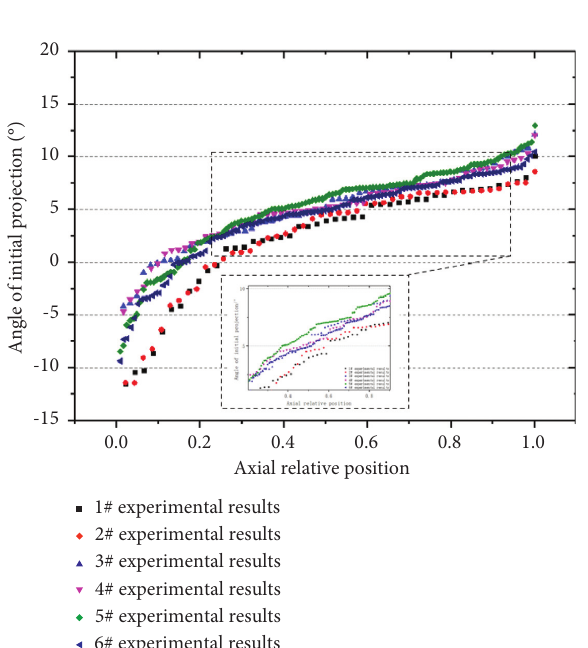
Figure 6: Test value of combat fragmentation dispersion